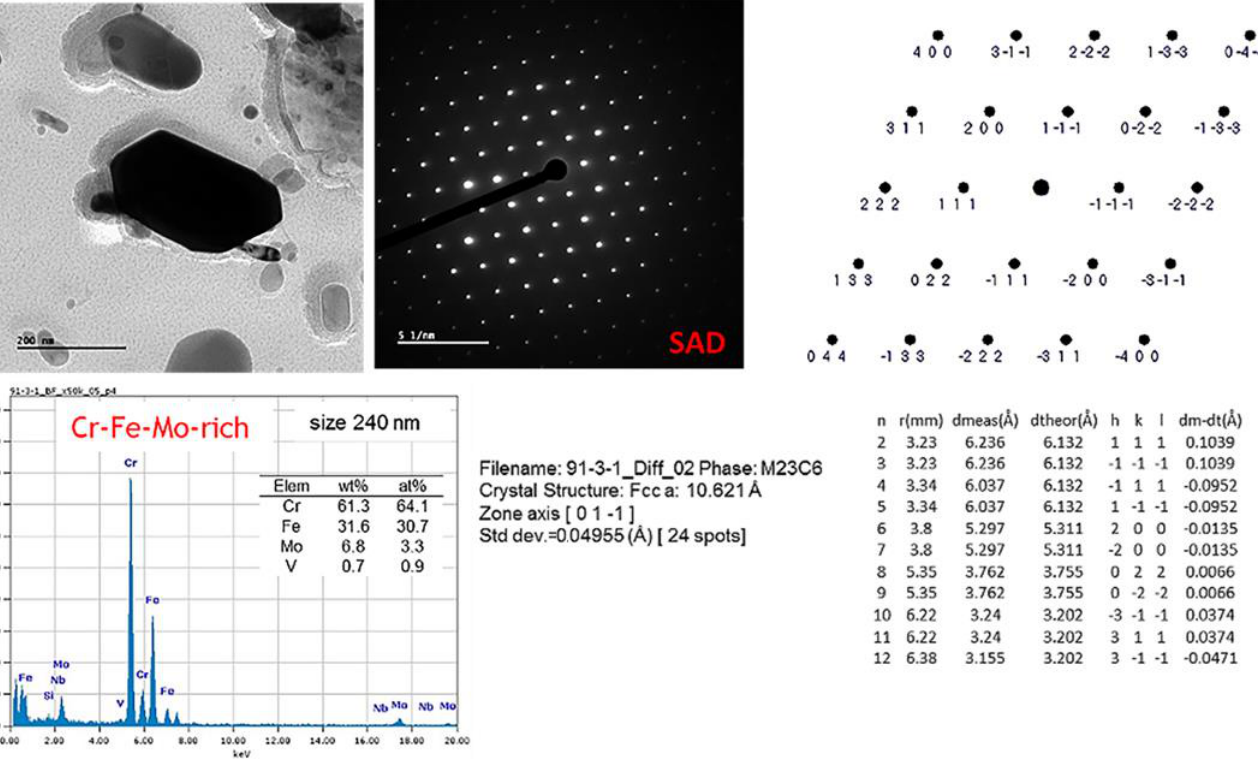
Figure 8. Failed crept cross-weld specimen 91-HAZ-3-1 550 °C 200 MPa 4395 h. TEM SAD (Selected Area Diffraction) and EDS (Energy Dispersive Spectroscopy) microanalysis on M 23 C 6 carbide.